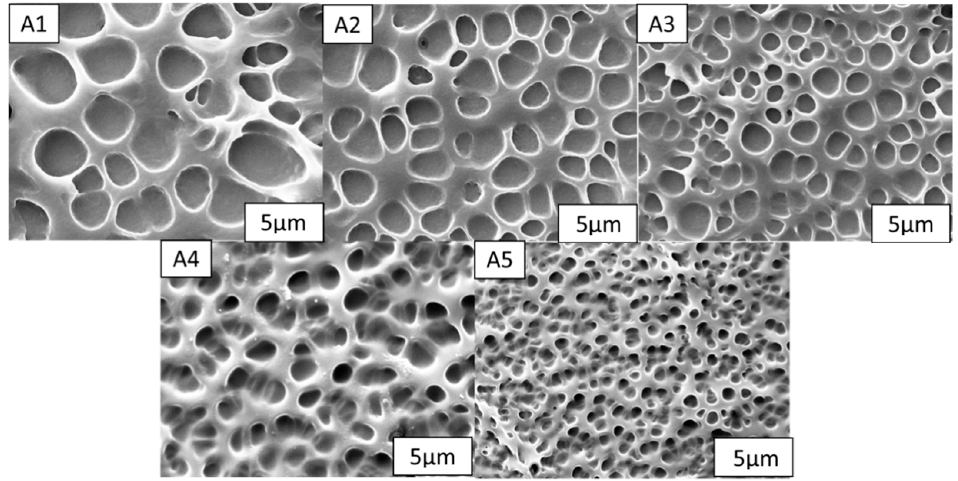
Figure 1. Network of the polymer matrices in specimens ( A1 – A5 ).